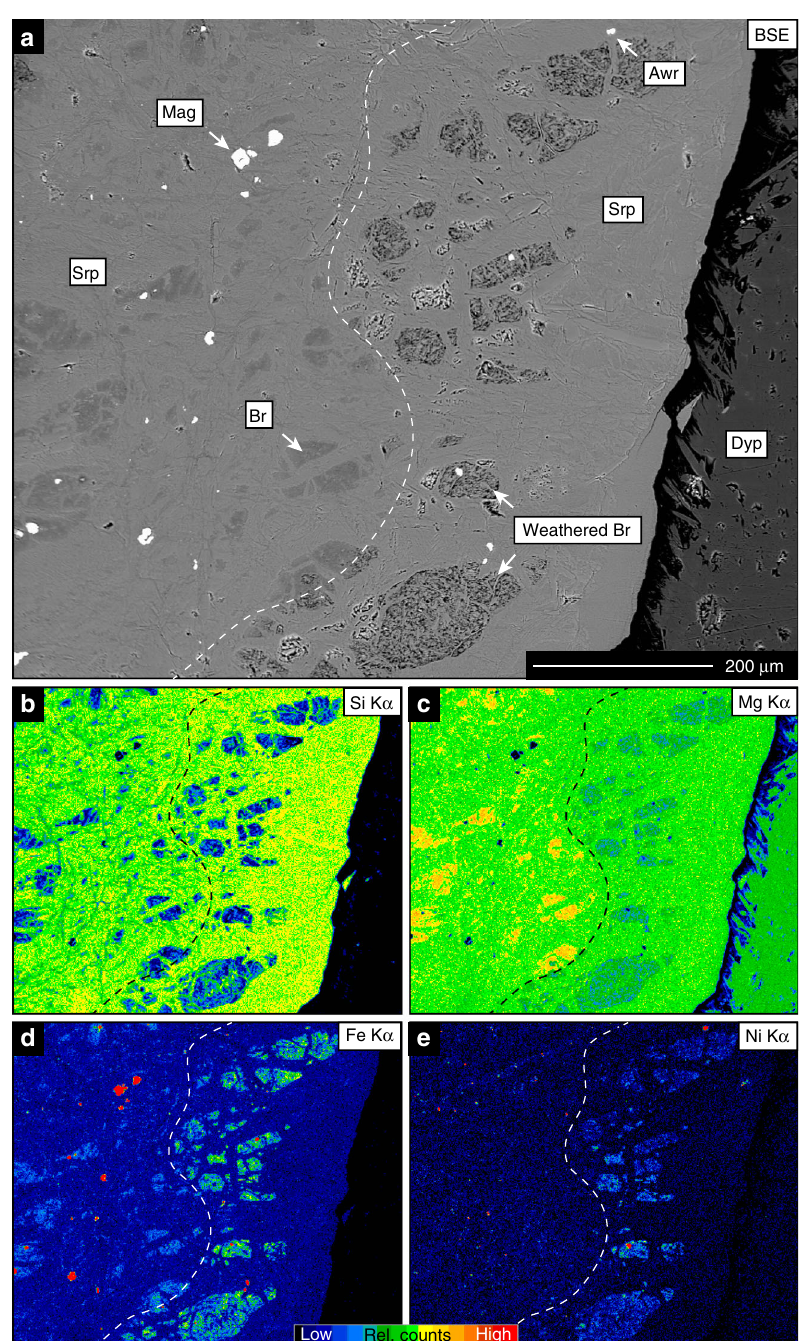
Fig. 4 Element distribution in low-temperature altered peridotite. Back-scattered electron (BSE) image ( a ) and qualitative element maps ( b – e ) across a cold-temperature weathering front in serpentinised peridotite from Feragen, eastern Norway. Weathering results in preferential dissolution of brucite from the weathered part of the sample (right hand side of the weathering front). Sites previously fi lled with brucite are porous and enriched in Ni and Fe. The dashed line indicates the approximate position of the weathering front. Secondary Mg-carbonate (dypingite) has formed on the surface. Br = brucite, weathered Br = site of brucite dissolved during weathering, Dyp = dypingite surface ef fl orescence, Mag = magnetite, Srp =